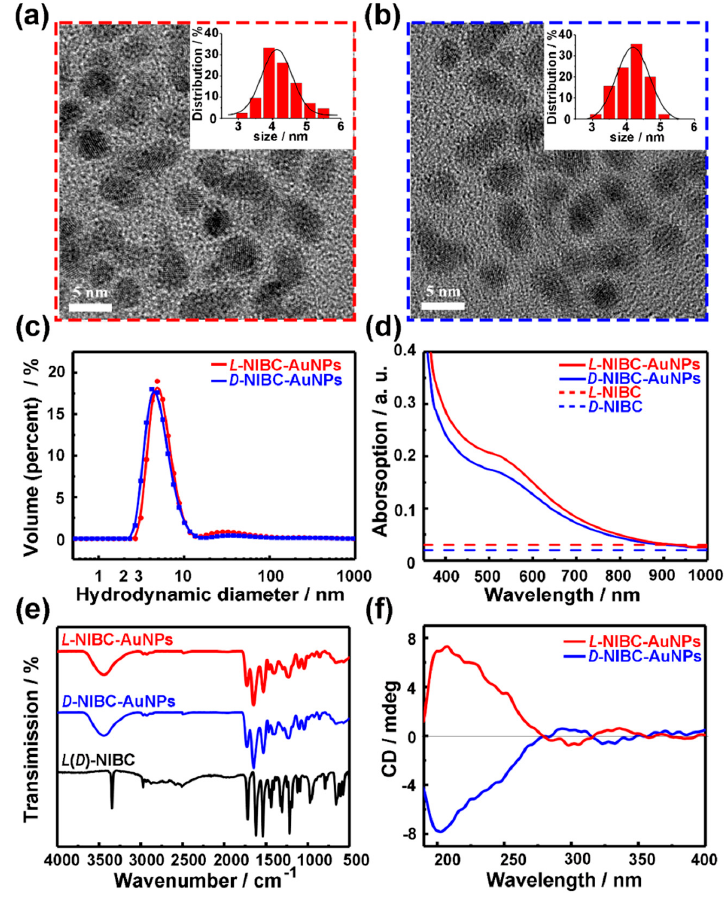
Figure 1 . HR-TEM images of L -NIBC-AuNPs ( a ) and D -NIBC-AuNPs ( b ). Insets of a and b are the histograms of diameter distribution for L ( D )-NIBC-AuNPs. DLS results ( c ), UV-Vis spectra ( d ), FT-IR spectra ( e ) and CD spectra ( f ) of L -NIBC-AuNPs (red curve) and D -NIBC-AuNPs (blue curve). Dotted lines in ( d ) and black curve in ( e ) represent L ( D )-NIBC.